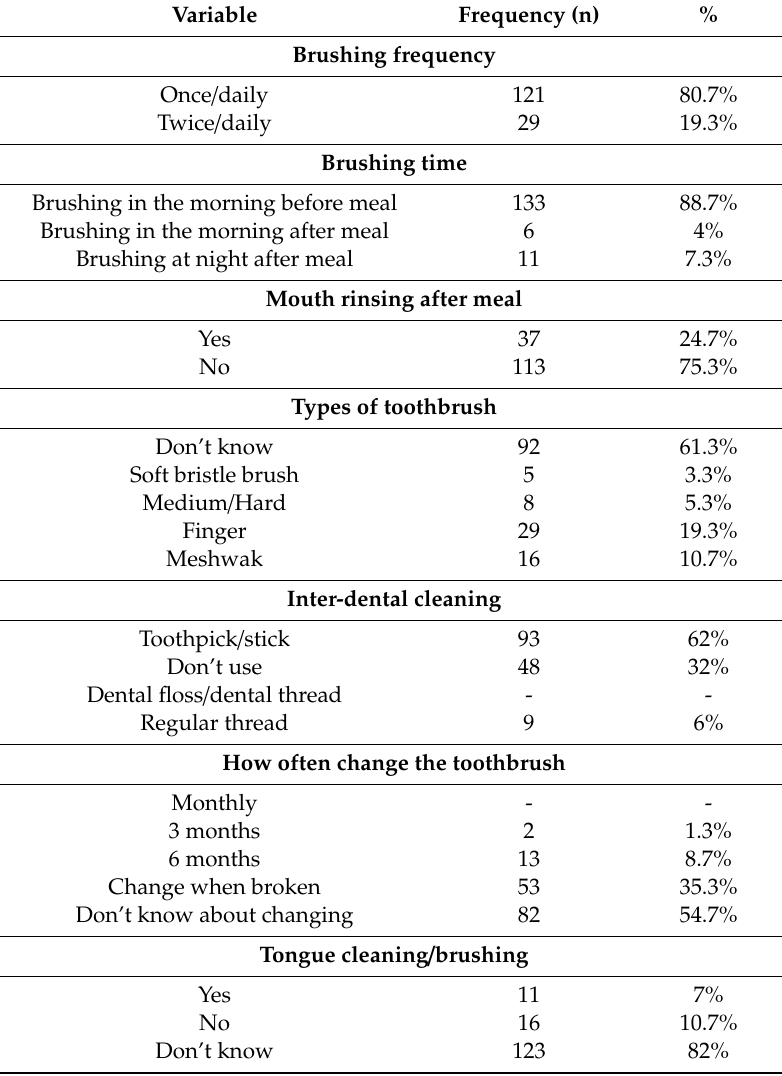
Table 2. Oral-health-related awareness among the